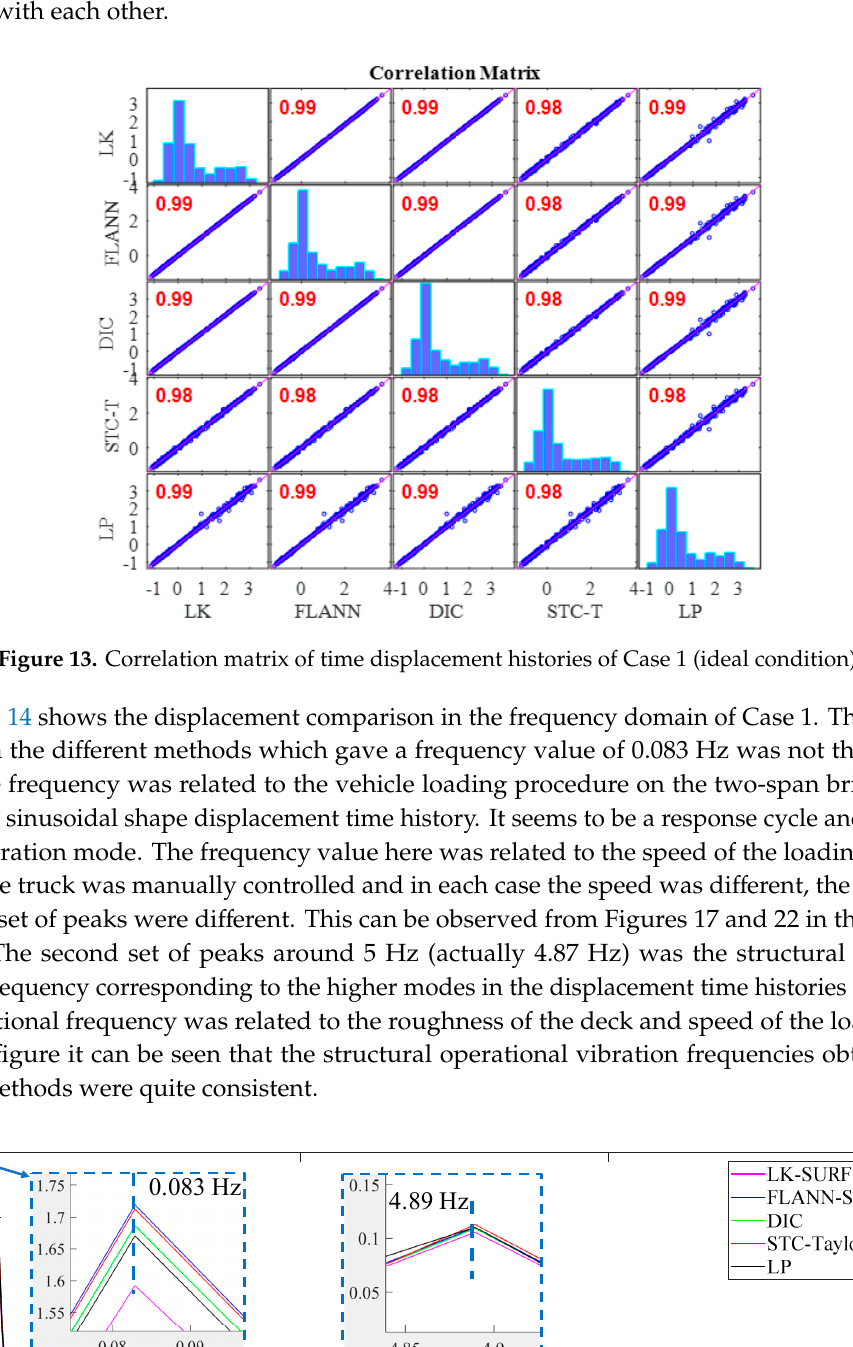
F Figure 15. Case 2 (illumination change): ( a ) displacement time histories of P1 obtained from different methods and ( b ) average image intensity time history. The spikes in Figure 15a show that the vision-based method FLANN-SURF was apparently influenced by the illumination change, which means FLANN-SURF cannot handle this kind of situation compared to other vision-based methods. Figure 15b shows the average image light intensity time history and it is easy to see the illumination change (36 lux to 18 lux) from the tooth-shaped signal. The green, dashed boxes A, B, C, and D indicate the corresponding illumination changes when FLANN-SURF gives spikes in its displacement measurement result. It is suspected that for the illumination changes as shown in boxes E and F, FLANN-SURF shows good consistency with other displacement measurement methods, while the possible reasons are unknown. As shown